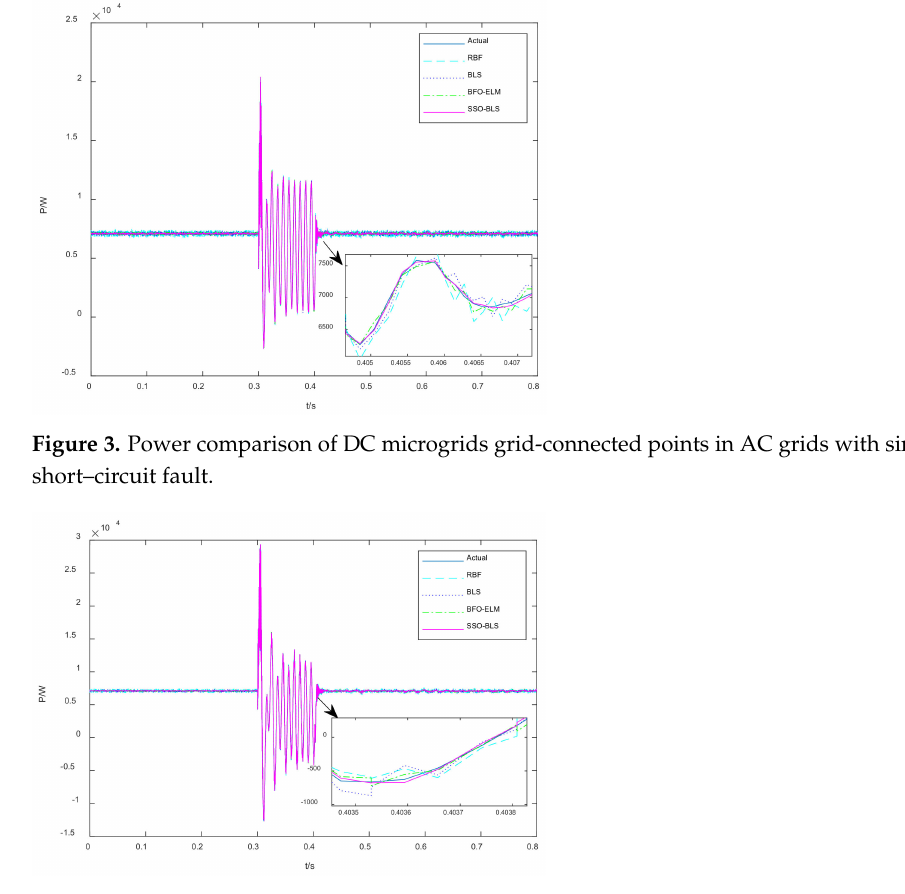
Figure 4. Power comparison of DC microgrids grid-connected points in AC grids with two–phase short–circuit fault.